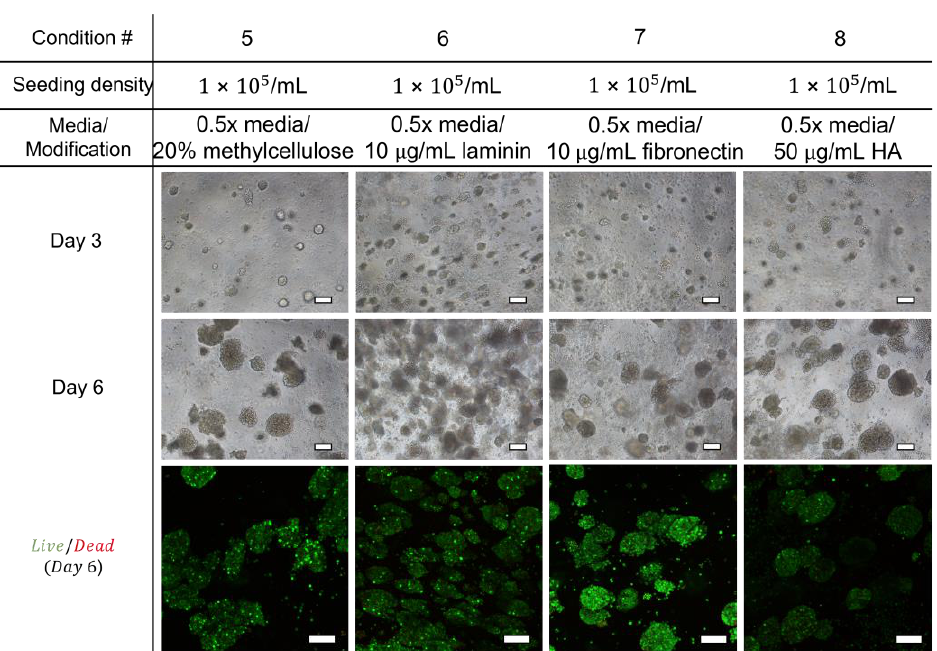
Figure 2. MLL-AF9 primary leukemia cells (mAF9) survive and form colonies in unmodified and modified self-assembling peptide hydrogels. Phase-contrast (top panel) and confocal images (bottom panel) of mAF9 cells in defined conditions of modified peptide hydrogels. Confocal images were taken 6 days following initial seeding and stained with Calcein AM and Ethidium Homodimer-1 to indicate viability. HA = Hyaluronan; scale bars = 100 µm.